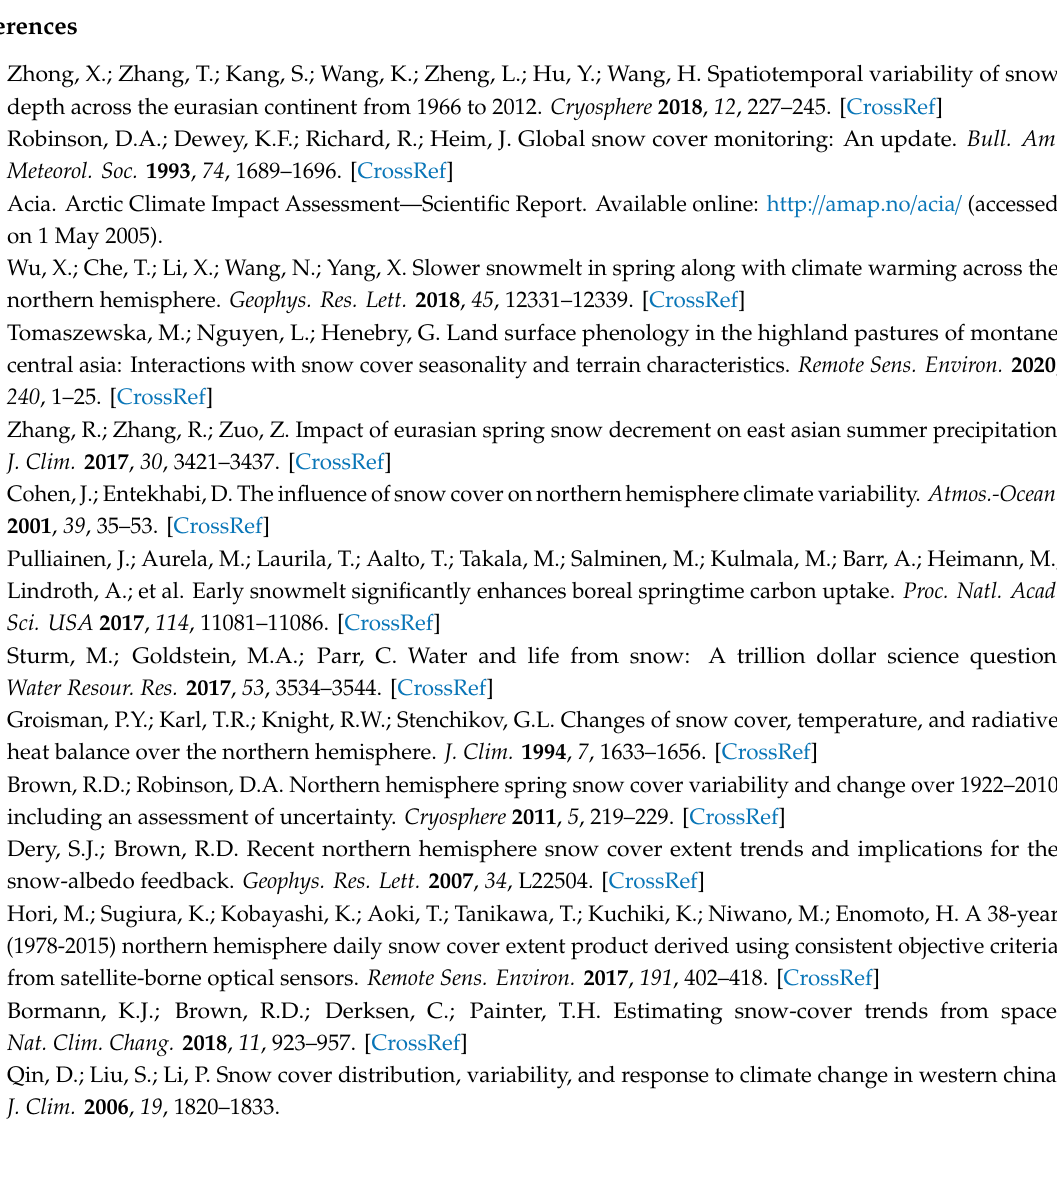
Figure S1: Spatial distributions of seasonal precipitation trends over the NH from 1967 to 2018, based on CRU TS 4.0. Only the significant ( p < 0.1) trends are shown, Figure S2: Map of the correlation coe ffi cients between SCE and precipitation in four seasons over the NH during the period of 1967–2018. The color indicates the direction and strength of those trends significant at the p < 0.1